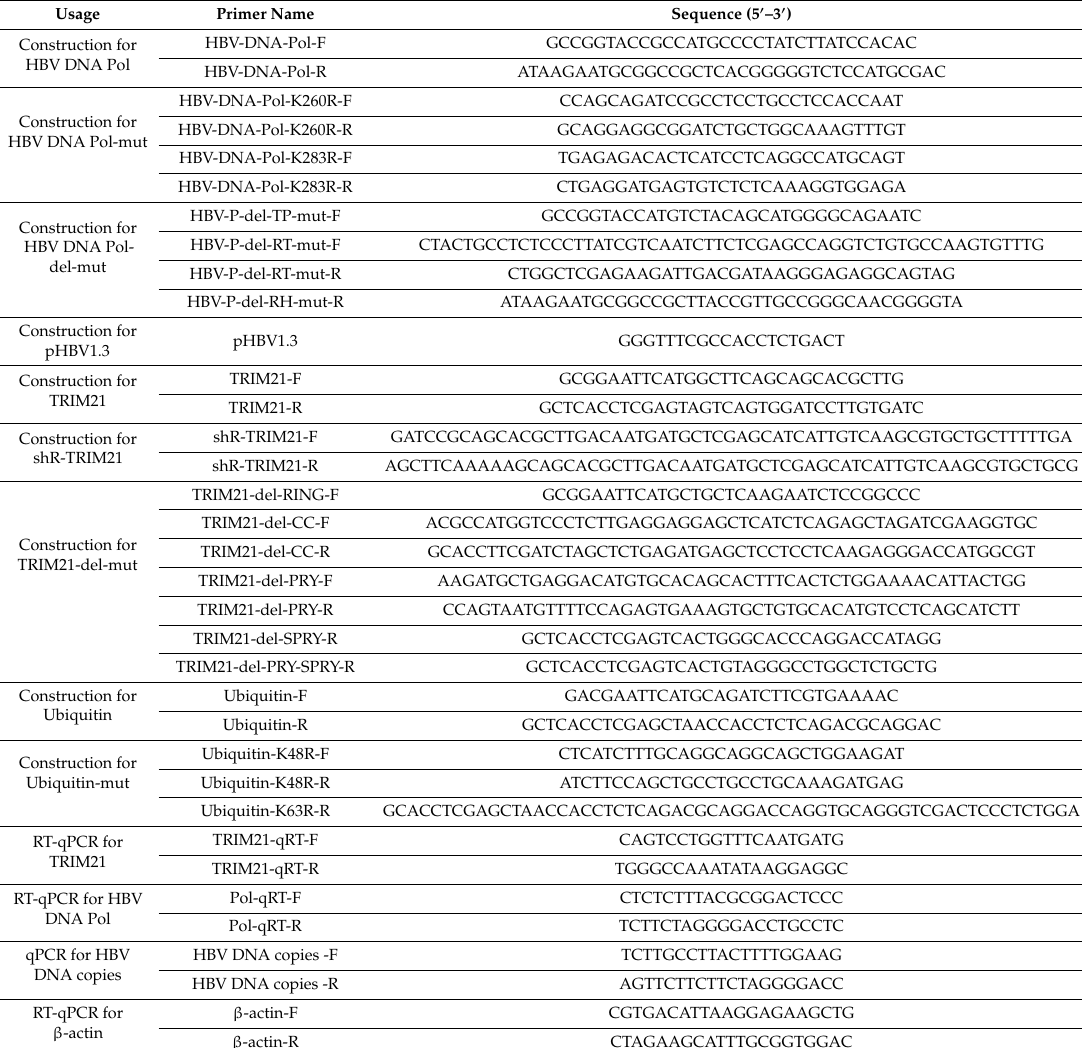
Table 1. The primers and oligonucleotides used in this